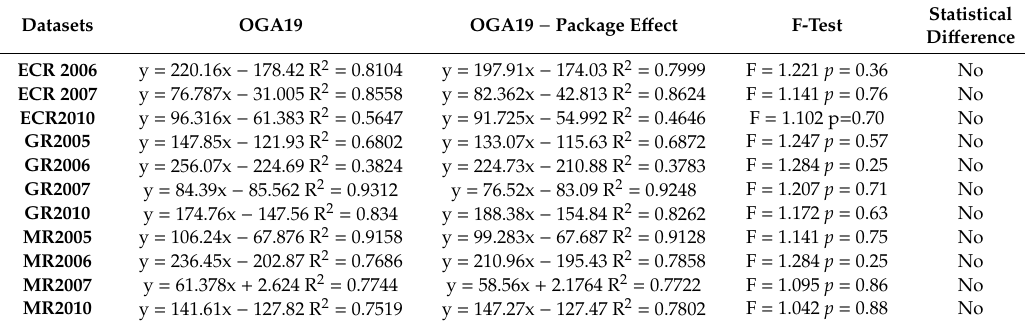
Table 10. Comparison between OGA19 performances with and without the package e ff ect correction for all